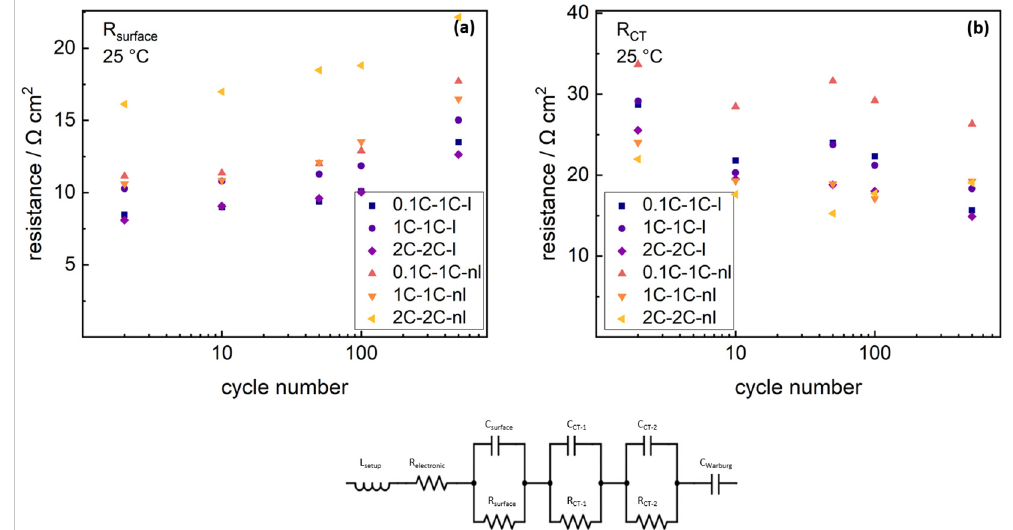
Figure 7. EIS resistance fit parameters of laminated and non-laminated single cells along cycling test (500 cycles total) after varied formation rate (2 initial cycles); equivalent circuit model indicated; data normalized to geometric electrode area; ( a ) trend of surface resistance; ( b ) trend of anode and cathode charge-transfer resistance sum.